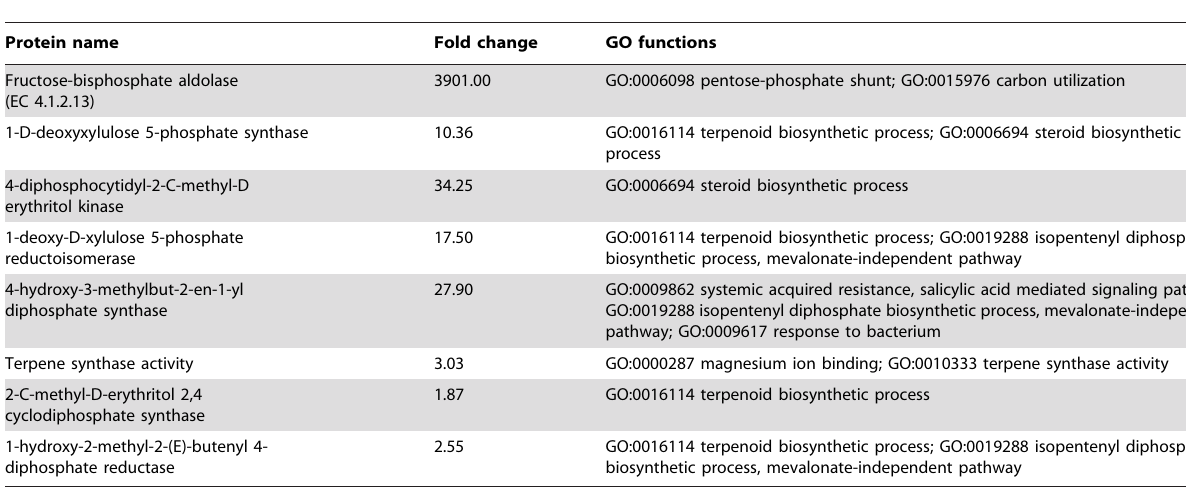
Table 5. List of upregulated isoprene/terpene biosynthesis genes in C. amada.